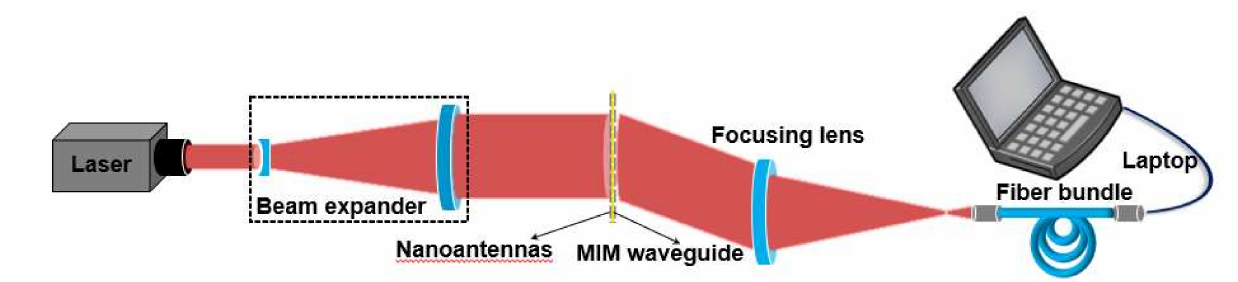
Figure A8. Sketch of the experimental setup used to couple the light into the MIM